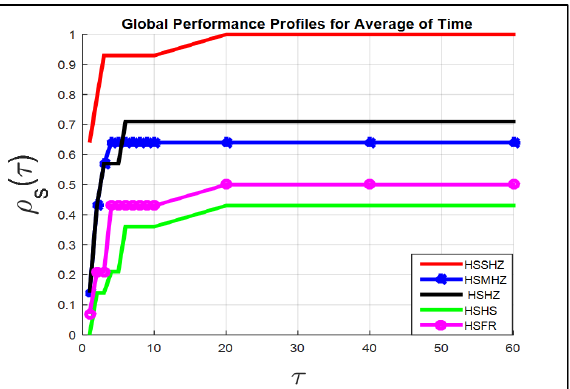
Figure 7. Plotting the results of the term time.a “CPU” for 5